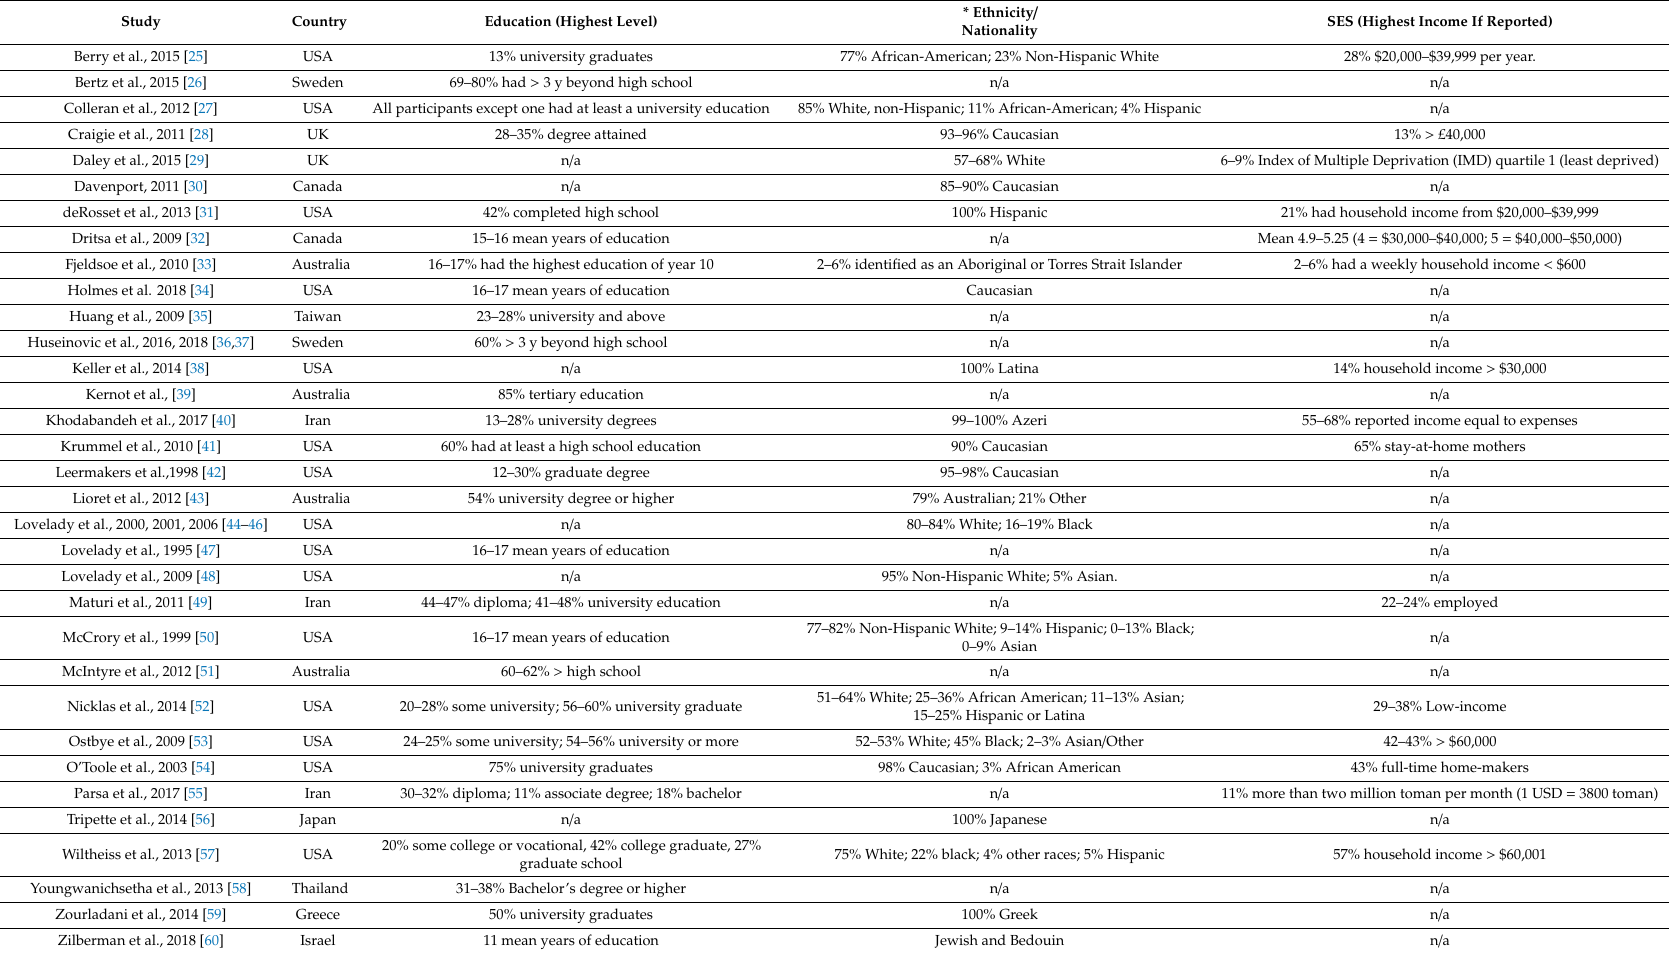
Table 2. Description of cohorts reported in the included